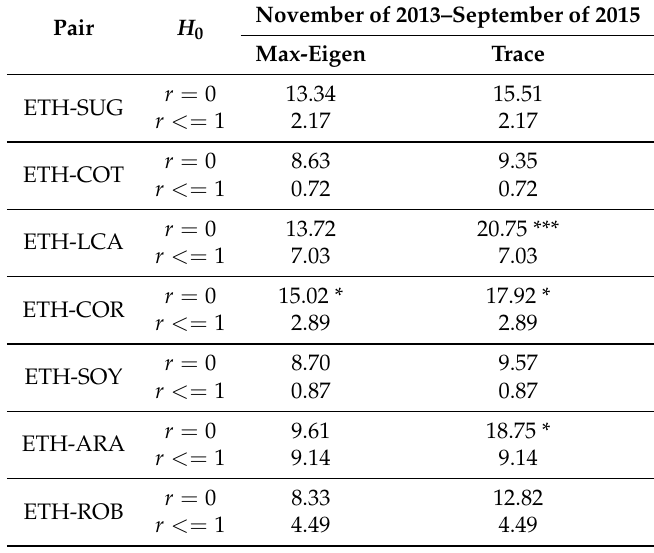
Table A4. The Johansen test for P 3 . Significance levels: 10% (*), 5% (**) and 1%